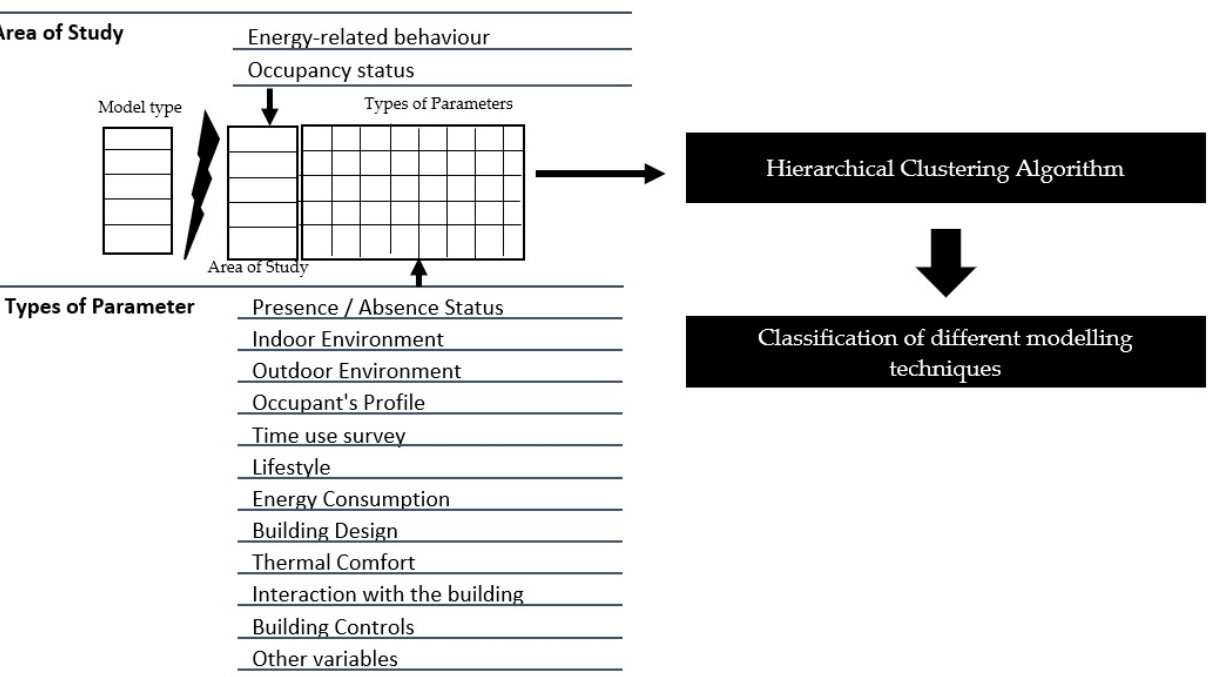
Figure 2. Clustering of different modelling techniques based on the “Area of Study” and “Types of